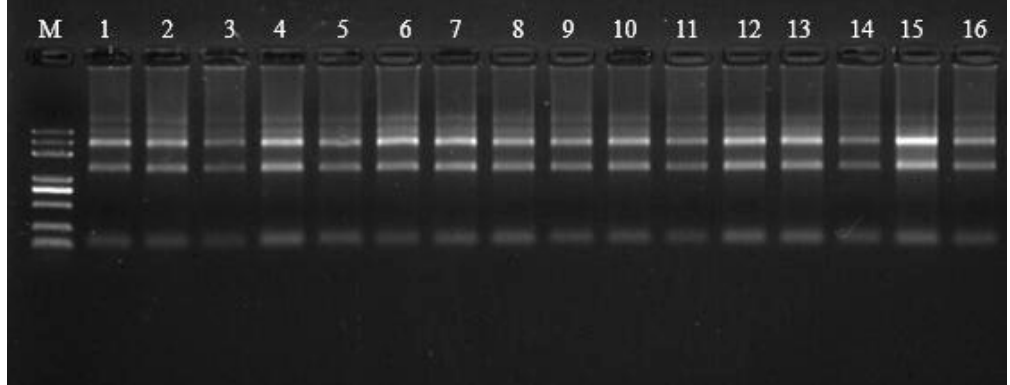
Figure 4. Quality report by 1% agarose gel electrophoresis. The marker is Trans 2K Plus. The figure corresponds to the following sequences: sequences 1, 2, 7, and 11 were diluted 20-fold; sequences 4, 8–10, 12–14, and 16 were diluted 10-fold; and the samples were 1 μ L. Sequence 5 was diluted sevenfold, and the sample was 1 μ L. Test parameters: gel concentration, 1%; voltage, 180 v; and electrophoretic time, 16 min. Agarose imaging was no less than three bands: 28 S, 18 S, and 5 S; the 28 S and 18 S bands were clear, and the brightness of 28 S was more than twice that of 18 S. The integrity of total RNA was better.